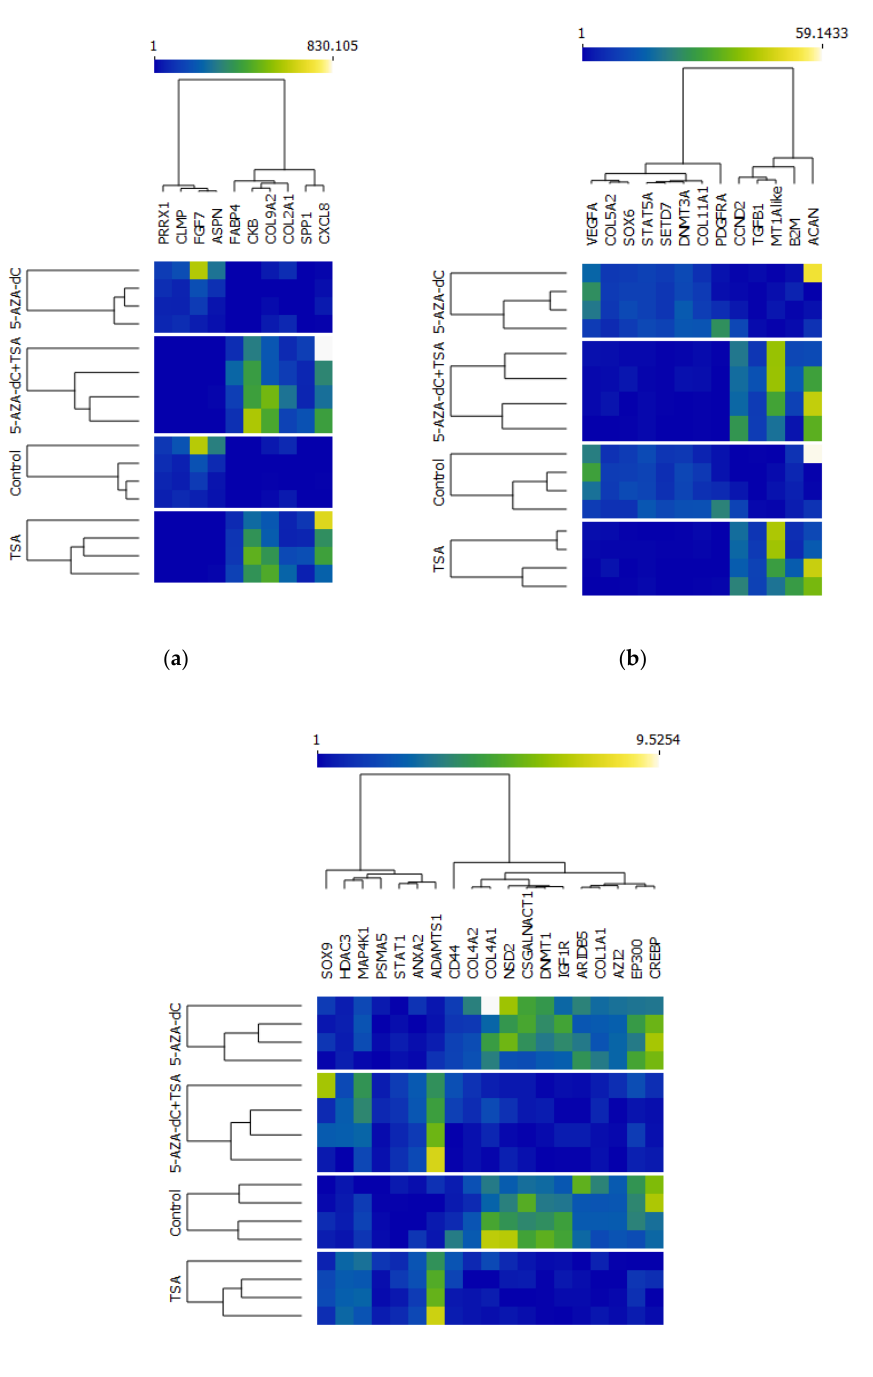
Figure 3. Differential expression results for 42 genes that are important for chondrogenesis and epigenetic modifications, which were validated using quantification with real-time PCR. Heat maps were generated using Orange: Data Mining web available software. Each heat map shows low expression values in blue and high expression values in yellow and white. In each figure, two major clusters are visible: the first represents genes downregulated after TSA or 5-AZA-dc+TSA treatment, and the second includes genes that were upregulated after TSA or 5-AZA-dc+TSA stimulation. ( a ) DEGs with fold changes of expression in the range from 1 to 830.1; ( b ) DEGs with fold changes of expression in the range from 1 to 59.14; ( c ) DEGs with fold changes of expression in the range from 1 to